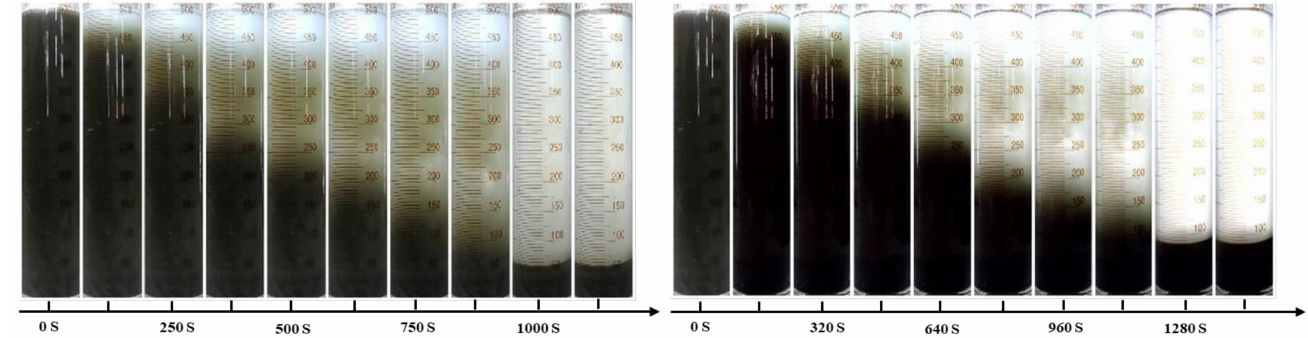
Figure 4. Settlement experiment: ( left ) mass concentration 15%, ( right ) mass concentration